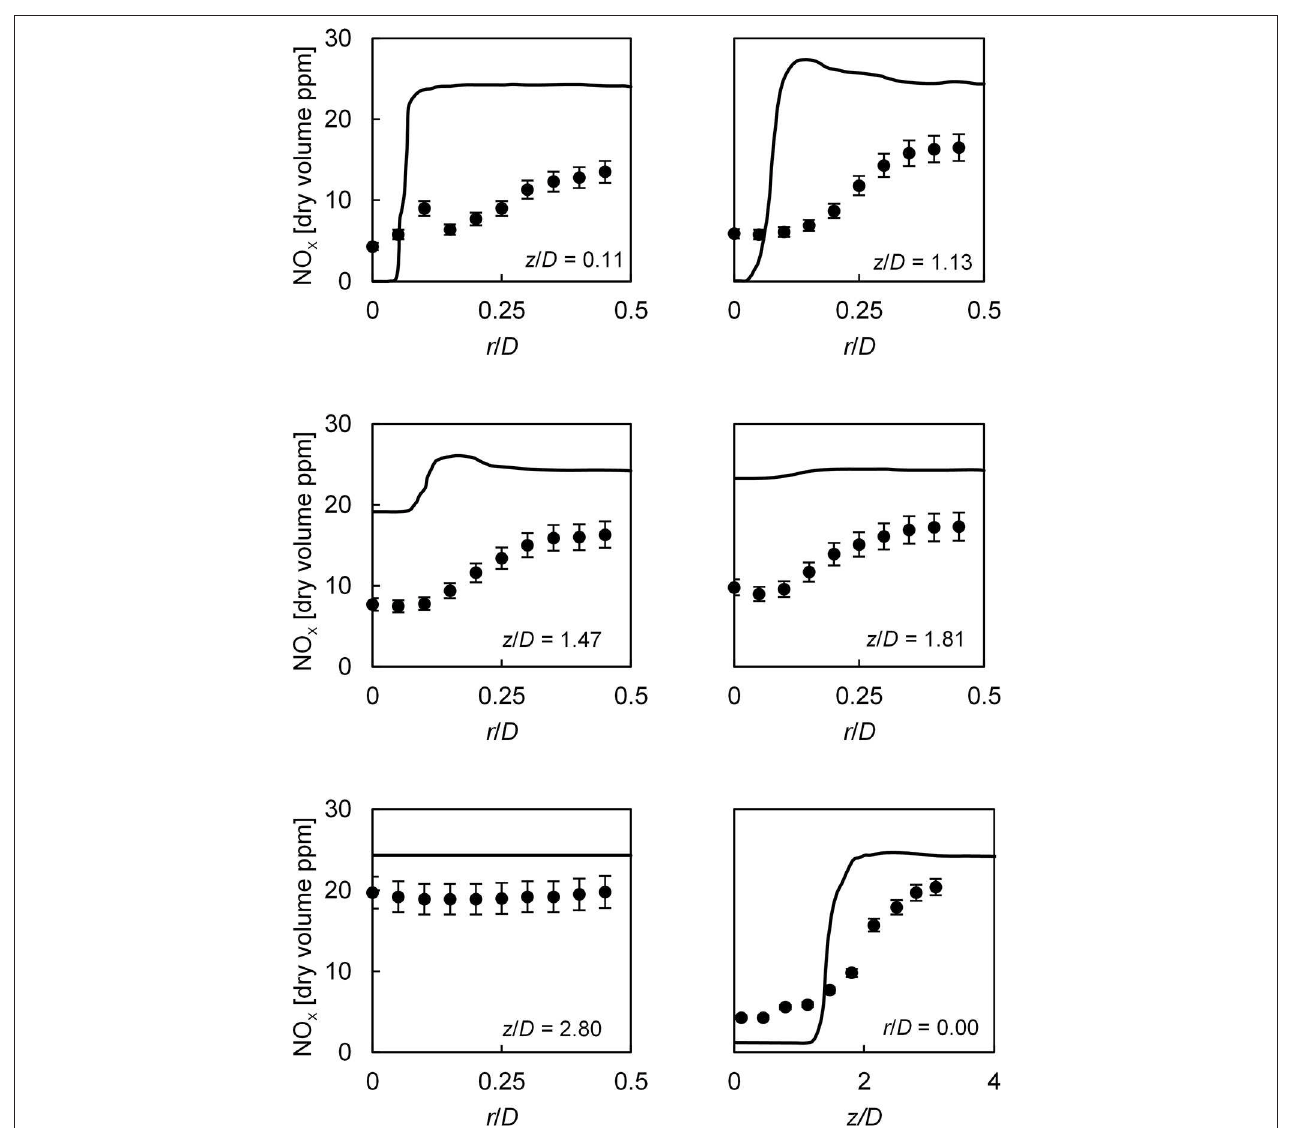
FIGURE 13 | NO x values at selected local profiles. Comparison between experimental data and AGNES results obtained using an FGM simulation as input, GRI 2.11 and T, velocity direction, Y H 2 O , Y CH 4 , and Y O 2 as clustering criteria for condition b ( φ ∼ =